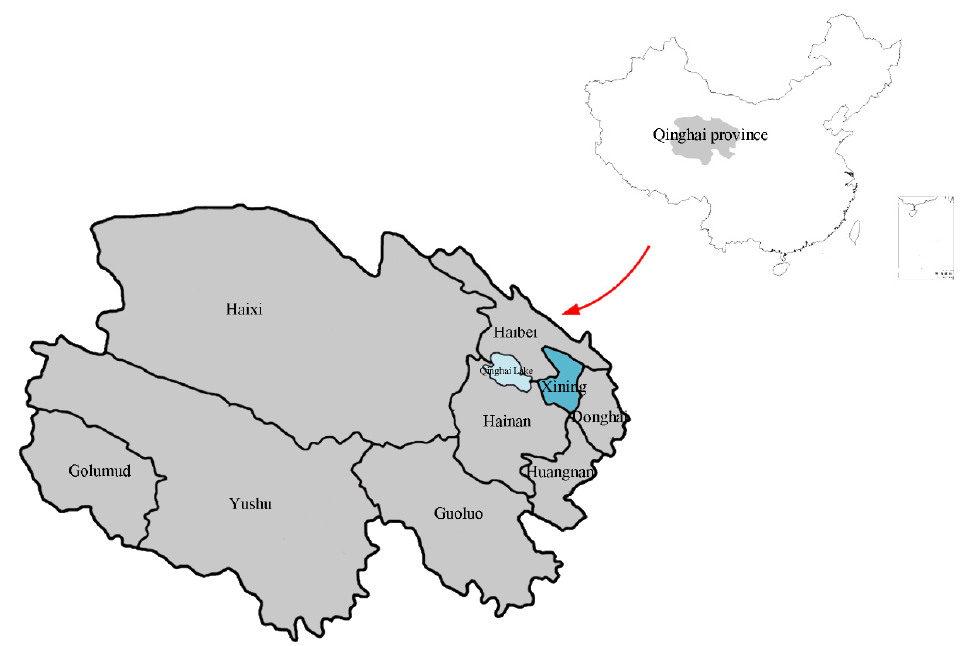
Figure 2. The geographic location of Xining in China .